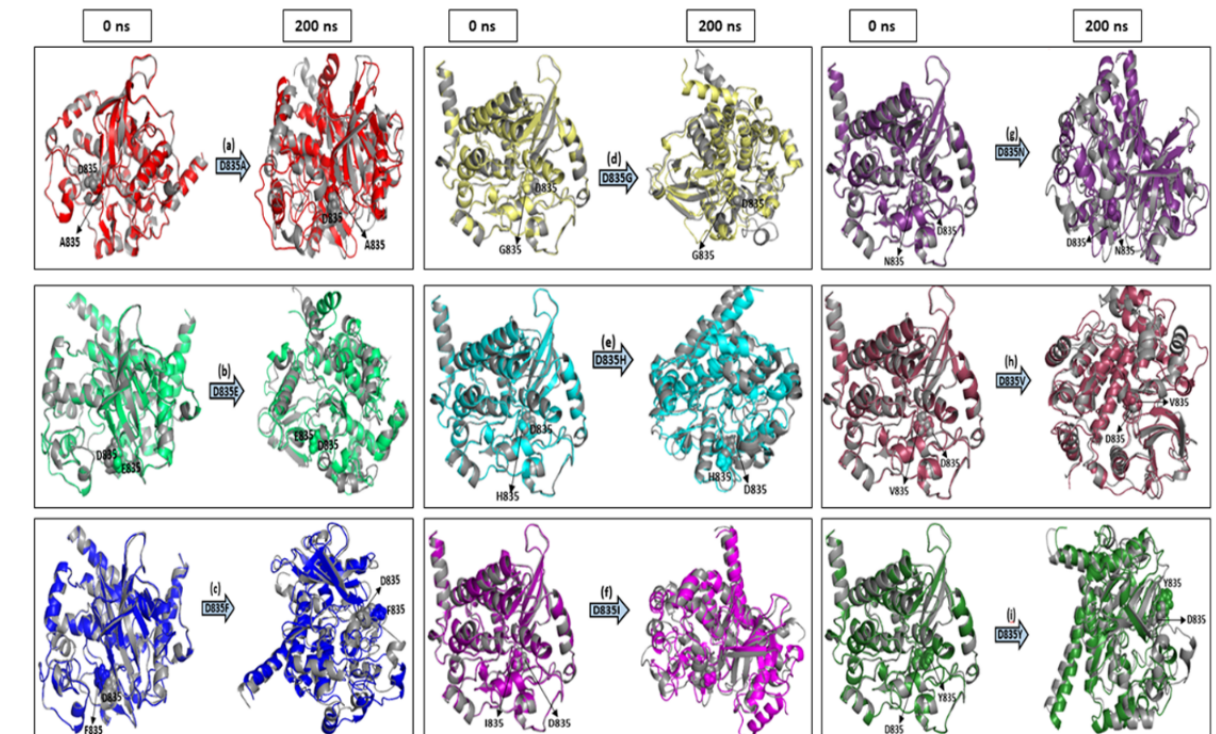
Figure 8. The beginning (0 ns) and end (200 ns) of the simulation snapshots of native and mutant FLT3 protein conformation were superimposed and represented in cartoon style. ( a ) Native vs. D835A (D835A mutant displayed in red color); ( b ) Native vs. D835E (D835A mutant displayed in green color); ( c ) Native vs. D835F (D835F mutant displayed in blue color; ( d ) Native vs. D835G (D835G mutant displayed in yellow color); ( e ) Native vs. D835H (D835H mutant displayed in cyan color); ( f ) Native vs. D835I (D835I mutant displayed in magenta color); ( g ) Native vs. D835N (D835N mutant displayed in purple color); ( h ) Native vs. D835V (D835V mutant displayed in maroon color); ( i ) Native vs. D835Y (D835Y mutant displayed in dark green color). Native FLT3 in all the snapshots shown in grey color. The mutation residues are displayed in sphere model.